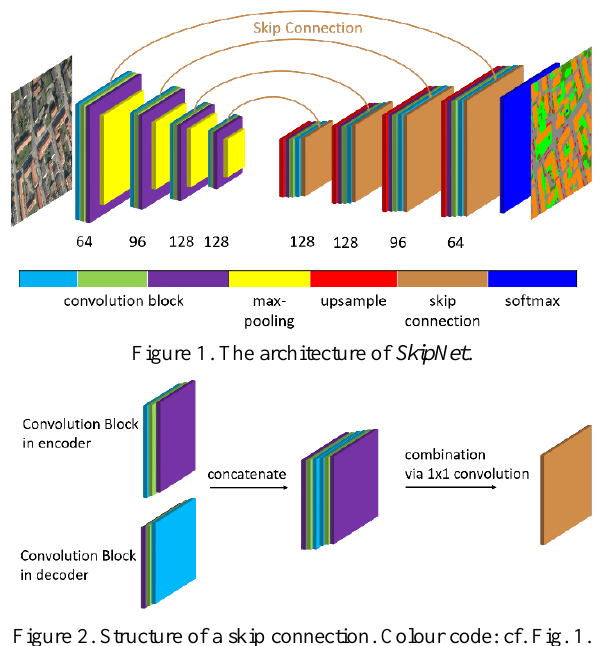
Figure 2. Structure of a skip connection. Colour code: cf. Fig. 1.